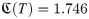
A tree with 8 leaves randomly generated under the α-γ-model with α = 0.7 and γ = 0.4.Its indices are C(T)=1.746, S(T) = 18, and Φ(T) = 14, and its normalized indices are Cnorm(T)=0.06518, Snorm(T) = 0.3704, and Φnorm(T) = 0.25.